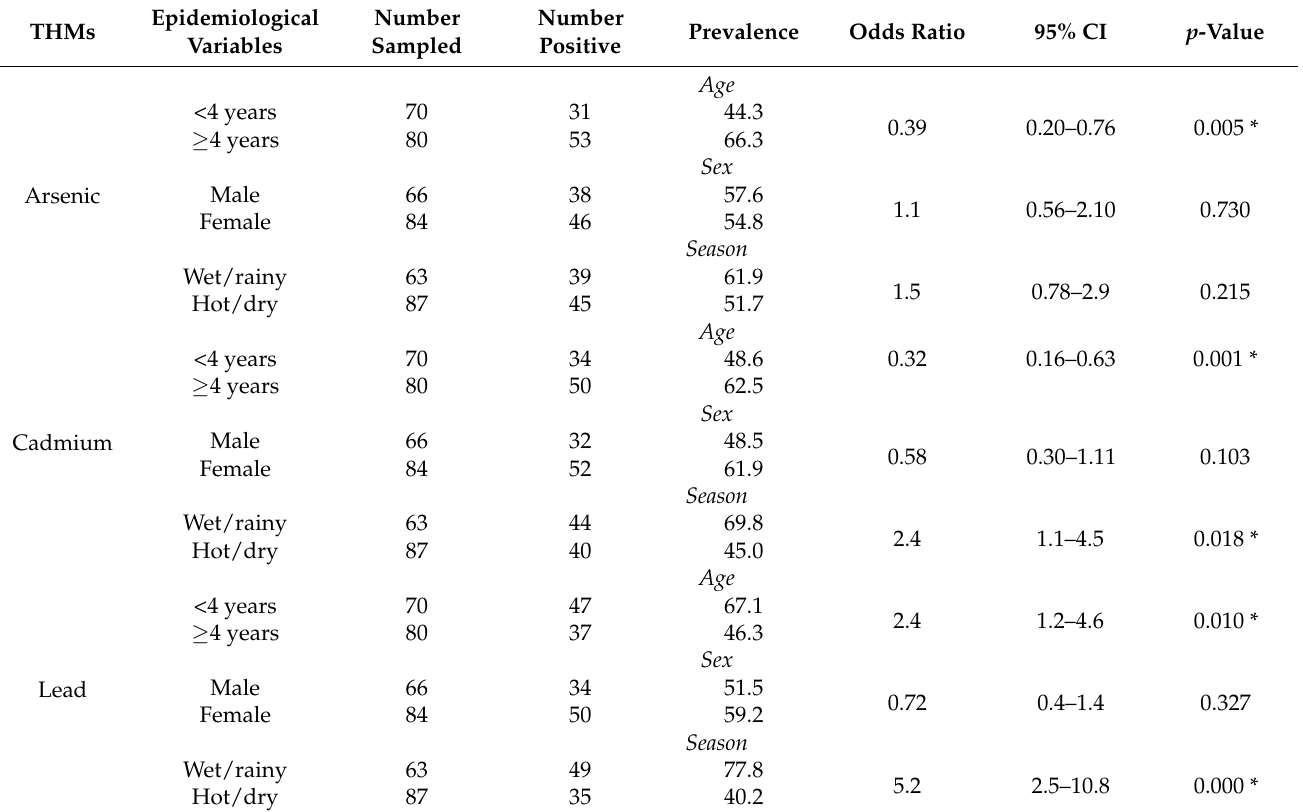
* Denotes statistical significance, based on Chi-square test, CI = Confidence